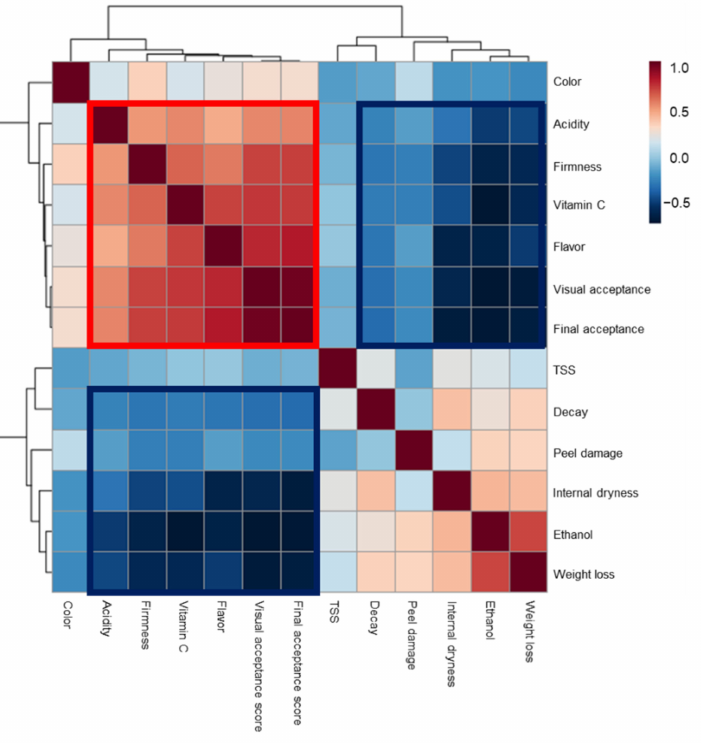
Figure 6. Pearson correlations and heat map analysis of the various fruit quality parameters of ‘Valencia’ fruit. Red and blue boxes indicate parameters that are positively and negatively correlated with one another,